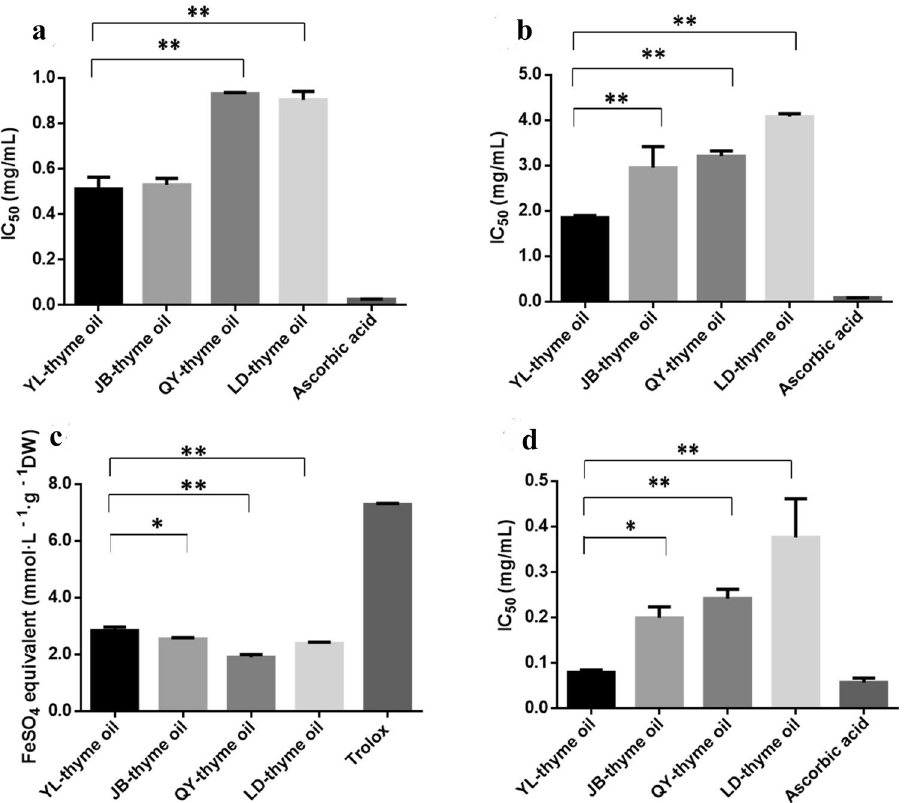
Figure 5. The IC 50 value of thyme oils on DPPH ( a ), ABTS ( b ) and TBARS ( d ) and FeSO 4 equivalent on FRAP ( c ). Results are presented as means ± SD ( n = 3). ** Represents p -value less than 0.01 and * represents p value less than